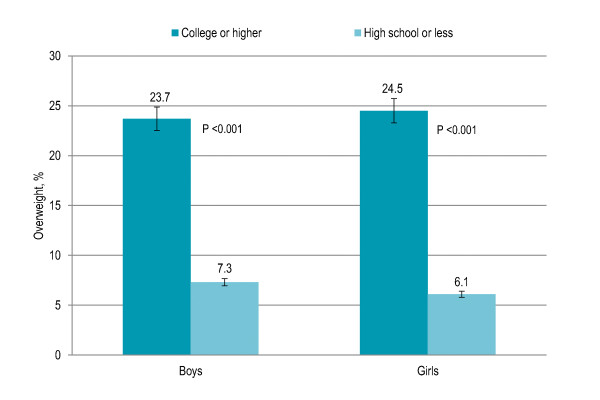
Gender-specific prevalence (with confidence interval bars) of overweight among Pakistani primary school boys (n = 977) and girls (n = 883) by parental education level.